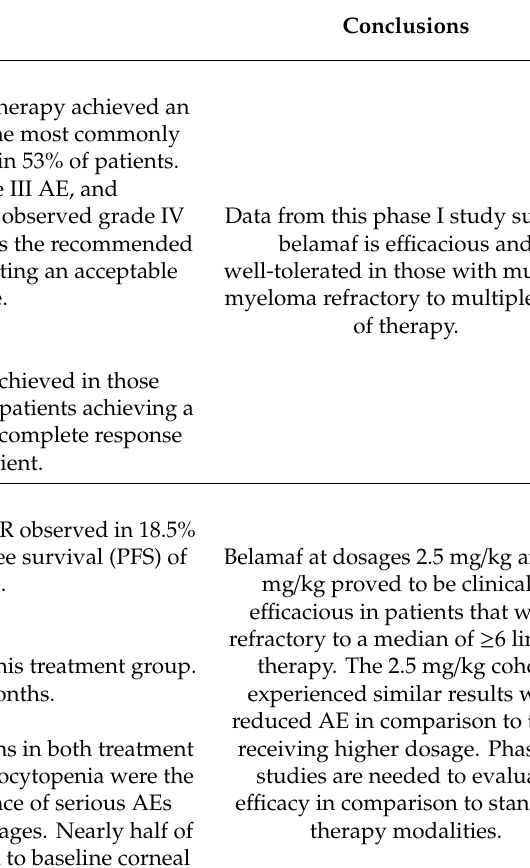
Table 2. Clinical E ffi cacy and